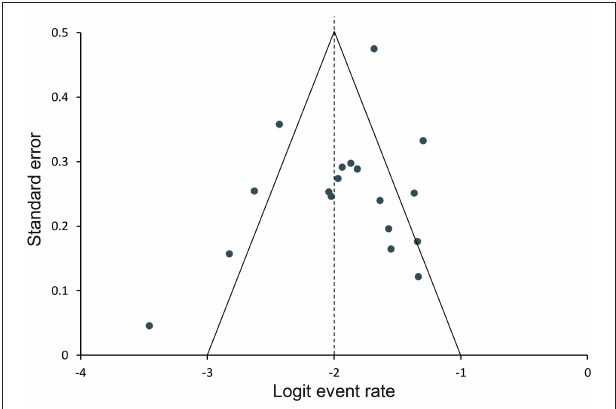
FIGURE 6 | Funnel plot for assessing publication bias. Data points represent individual studies. The y -axis represents the measurement of study precision (plotted as standard error of effect size), and the x -axis represents point estimates for each study. Dashed triangular lines represent the region in which 95% of studies are expected to lie in the absence of bias and